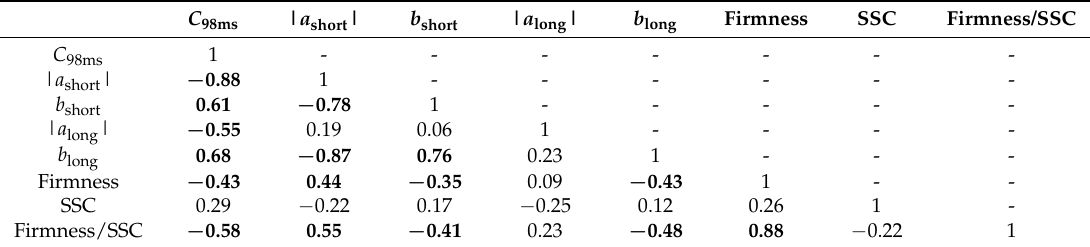
Table 1. Correlation coefficients calculated for C 98ms , | a short |, b short , | a long |, b long , firmness, soluble solids content (SSC), and firmness/SSC measured for the whole batch of apples. Values in bold indicate a significant correlation at p < 0.01. C 98ms | a short | b short | a long | b long